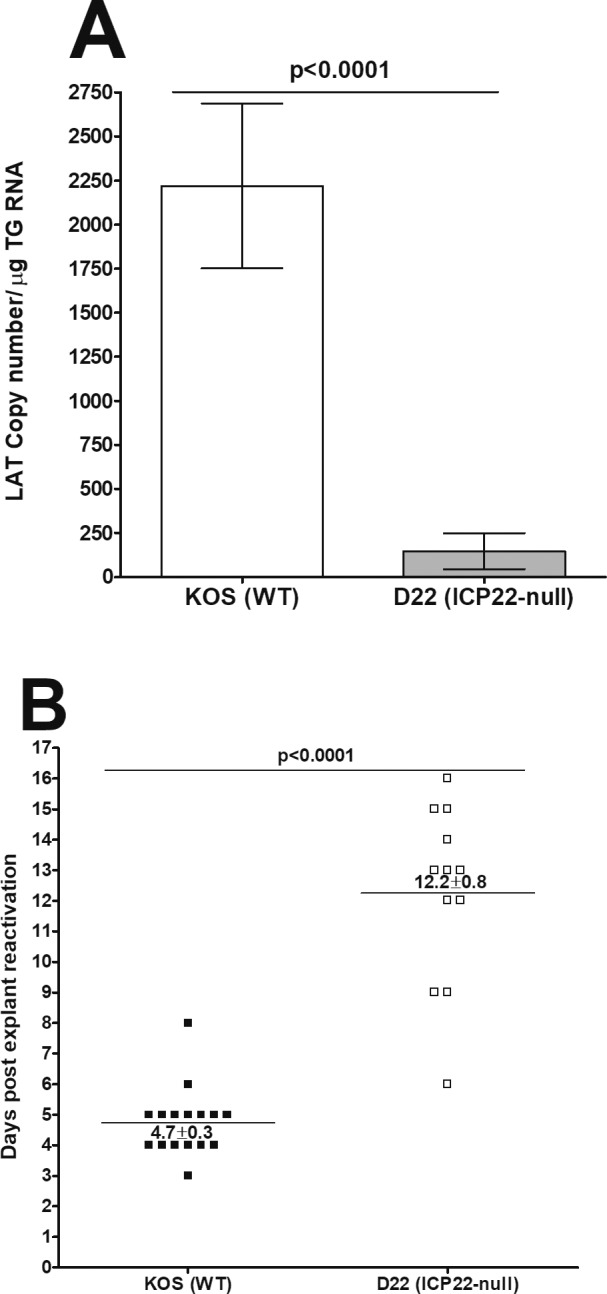
Level of latency and duration of explant reactivation following ocular infection of mice with avirulent KOS and ICP22 null viruses. Corneas from WT mice were scarified before ocular infection and infected ocularly with 2 × 105 PFU per eye of KOS or ICP22 null virus as in Figure 1. On day 28 PI, TG from infected mice were harvested for RT-PCR and explant reactivation. (A) LAT RNA in latent TG. Quantitative RT-PCR was performed on each individual mouse TG. In each experiment, an estimated relative copy number of HSV-1 LAT was calculated by using standard curves generated from pGem5317. The plasmid template was serially diluted 10-fold such that 10 μL contained from 103 to 1011 copies of LAT. Serial dilutions were then analyzed by TaqMan Real-time PCR with the same probe set. The copy number for each reaction was determined by comparing the normalized threshold cycle of each sample to the threshold cycle of the standard. GAPDH expression was used to normalize relative viral LAT RNA expression in the TG. Each bar represents the mean ± SEM from 18 TG for KOS-infected mice, and 16 TG for ICP22 null–infected mice. (B) Explant reactivation in latent TG. Individual TG from infected mice were incubated in 1.5 mL tissue culture media at 37°C and the presence of infectious virus was monitored at 20 days as described in the Material and Methods section. For each virus, 20 TG from 10 mice were used. The results are shown as the number of TG that reactivated daily. Each point represents the mean ± SEM from 16 TG for KOS and 12 TG for ICP22 null–infected mice. However, not all TG reactivated during the 20-day monitoring period: 4/20 KOS-infected TG and 8/20 ICP22 null–infected TG failed to reactivate. (A) LAT RNA. (B) Explant reactivation.